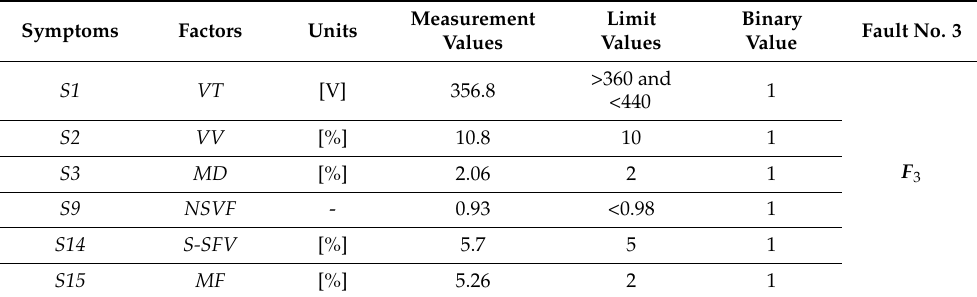
Figure 8. Phase-to-phase voltage U V-W (t) : fault no. 3 to the governor speed controller. Load rate 100% P n : 1, rated signal; 2, signal during the breakdown. Table 3. The armature voltage for GSC fault no. 3, F 3